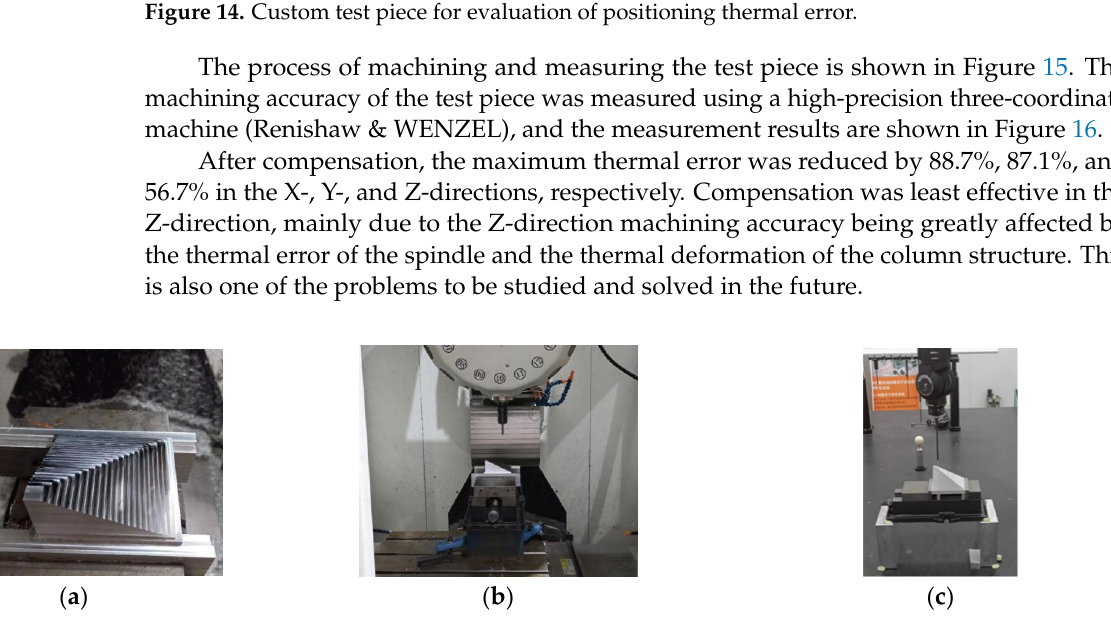
Figure 14. Custom test piece for evaluation of positioning thermal error.